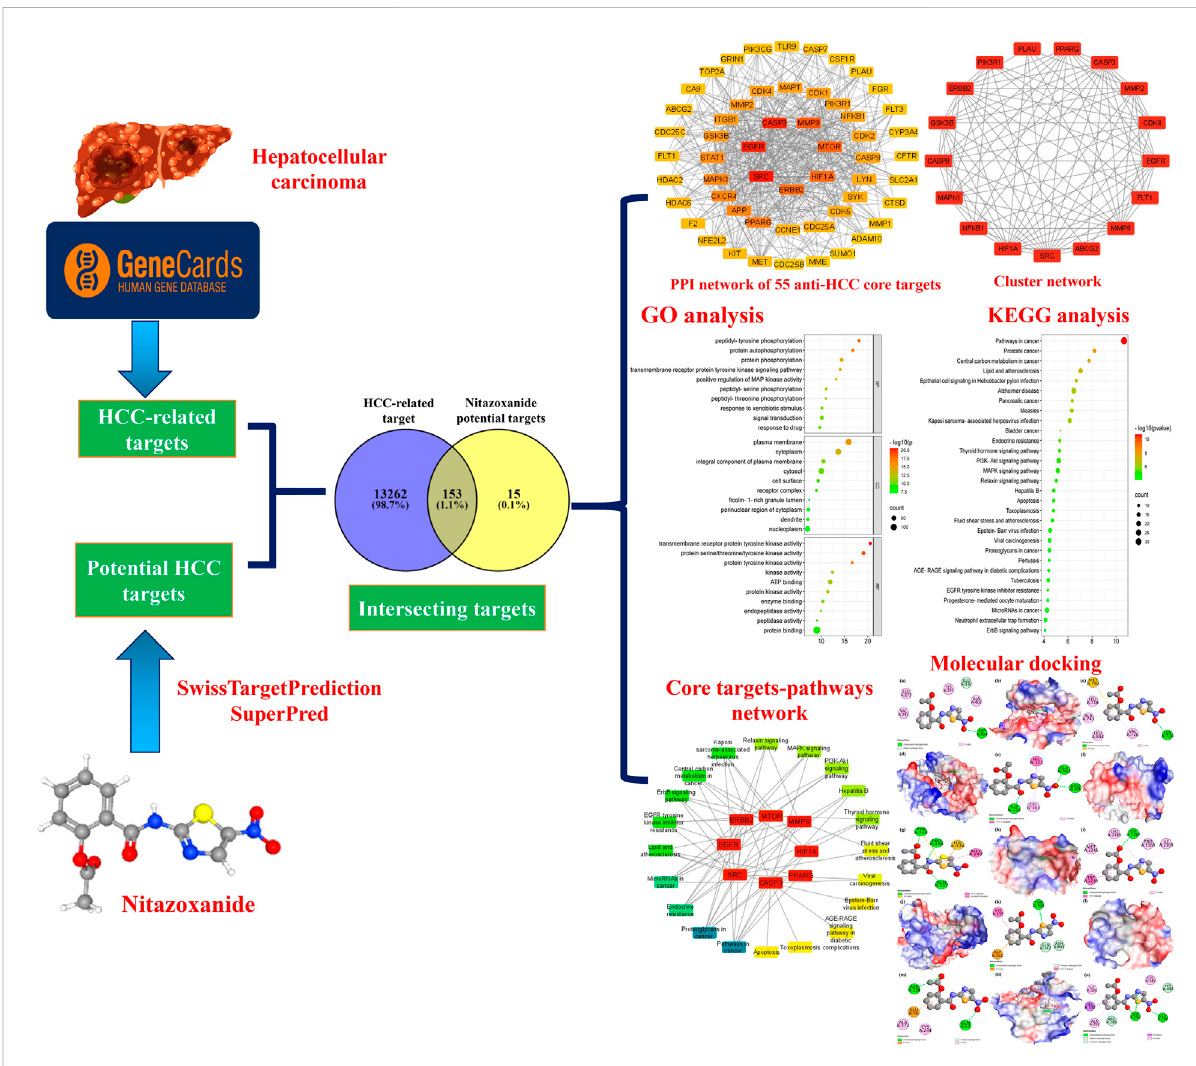
FIGURE 1 The fl ow chart of this